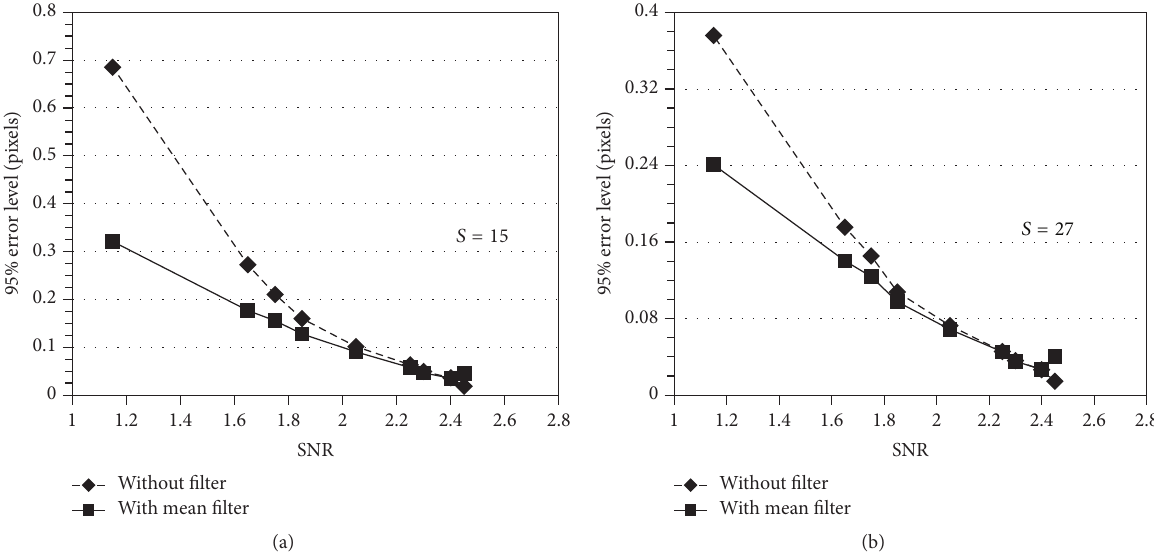
Figure 11: Effect of mean filter in reducing displacement error for different image SNRs using 15 × 15 (a) and 27 × 27 (b) source window, with LW = 11